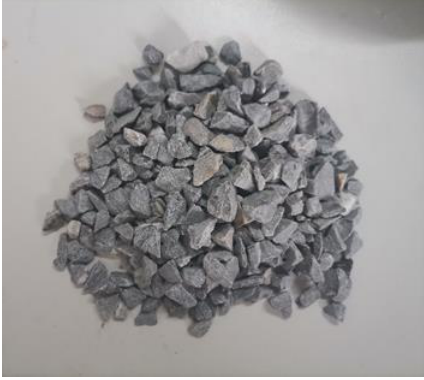
Figure 1. Image of aggregate sample.